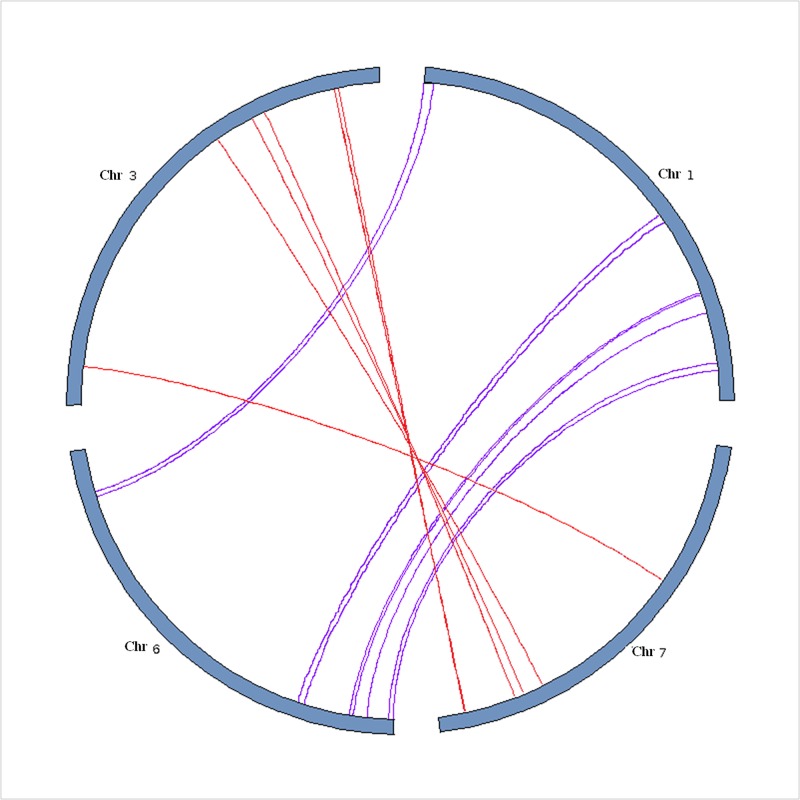
Duplicated genes pairs of EgWRKYs identified in this study.The coloured bars represent chromosomes of Elaeis guineensis.